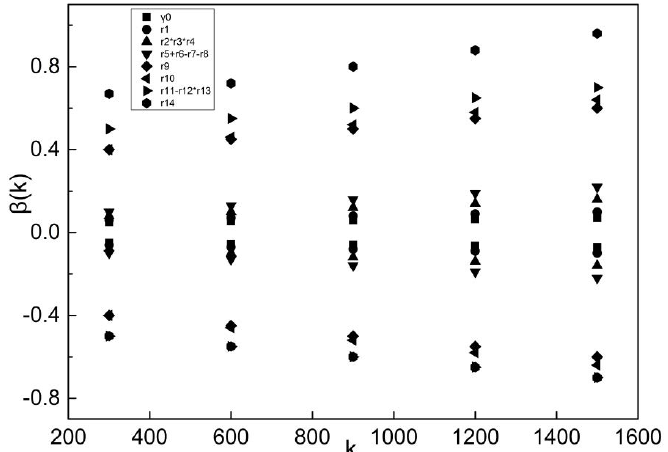
Fig. 3 Ridge plot of independent